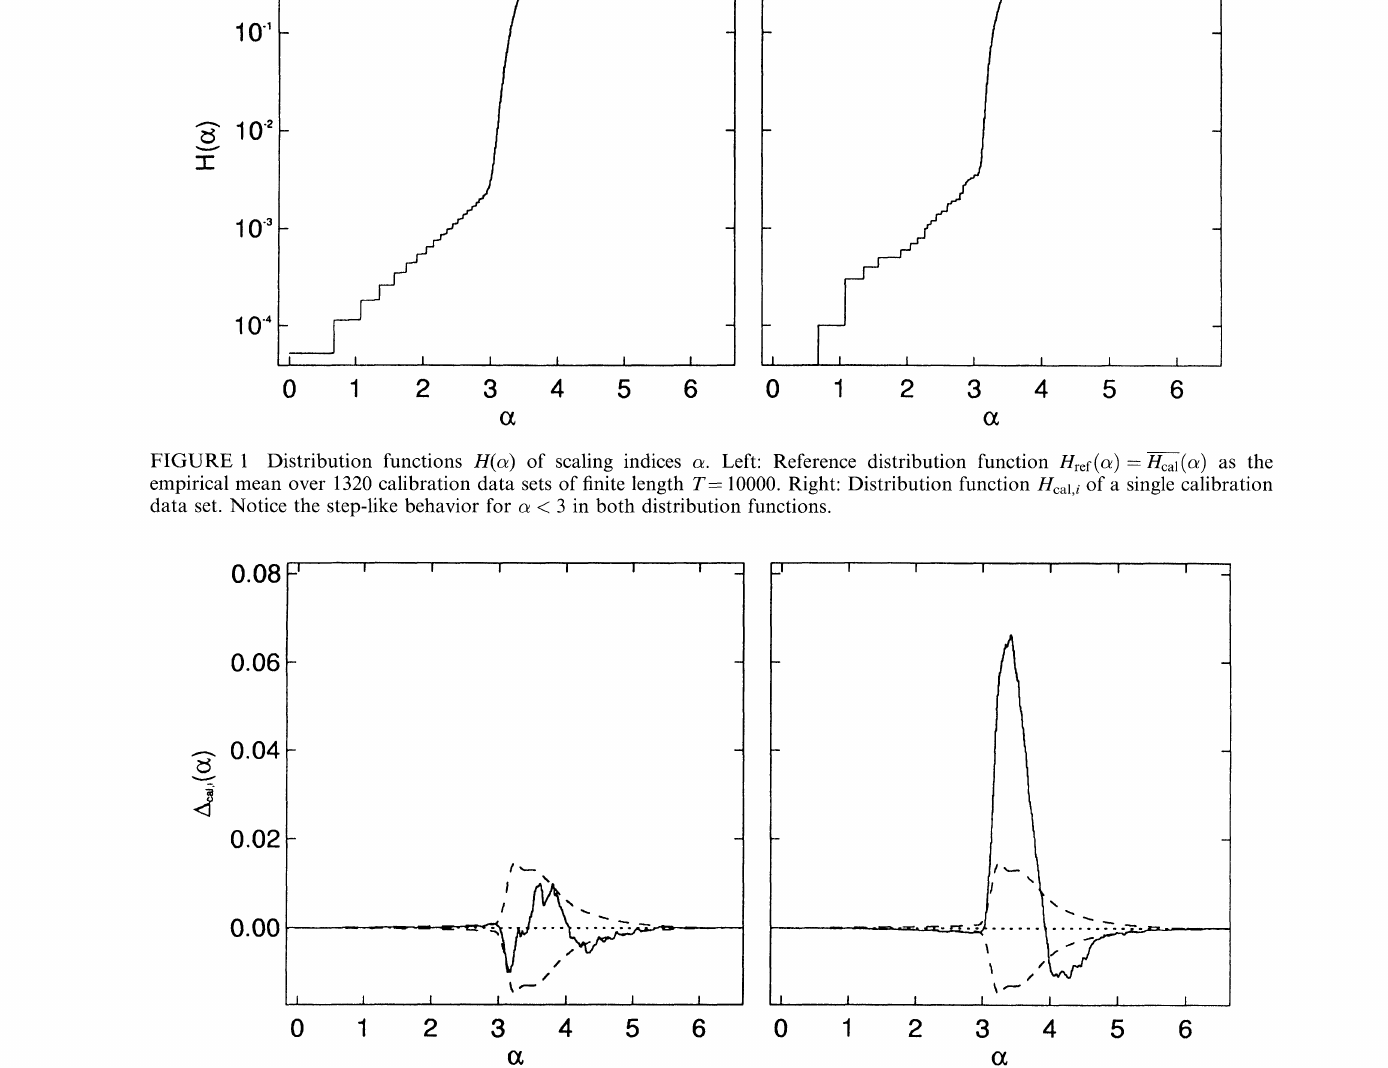
FIGURE 2 Deviation AcaU( of a single distribution function Hcal,;(c) from the reference distribution function Hrer(C). Left: Acau(C) for a single calibration time series. The dashed line indicates the lc contour of the calibration data sets used to calculate Hrer(c). Right: Aca,;(c for a time series generated with an i.i.d, random process of length T- 10000 with a binomial distribution B(182,0.55). The dashed line is the same la contour as in the left